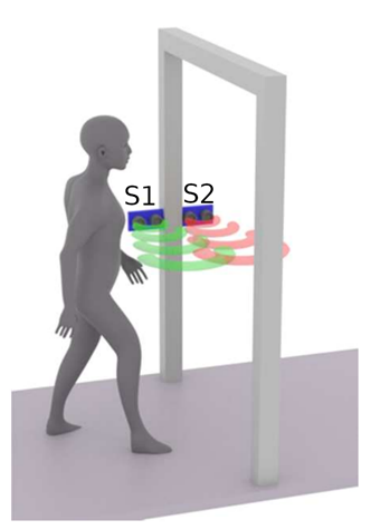
Figure 3. Principal functionality of Gate node.